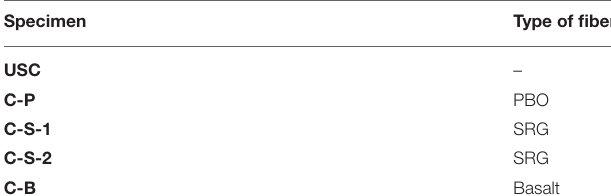
TABLE 2 | Geometrical details of tested specimens.